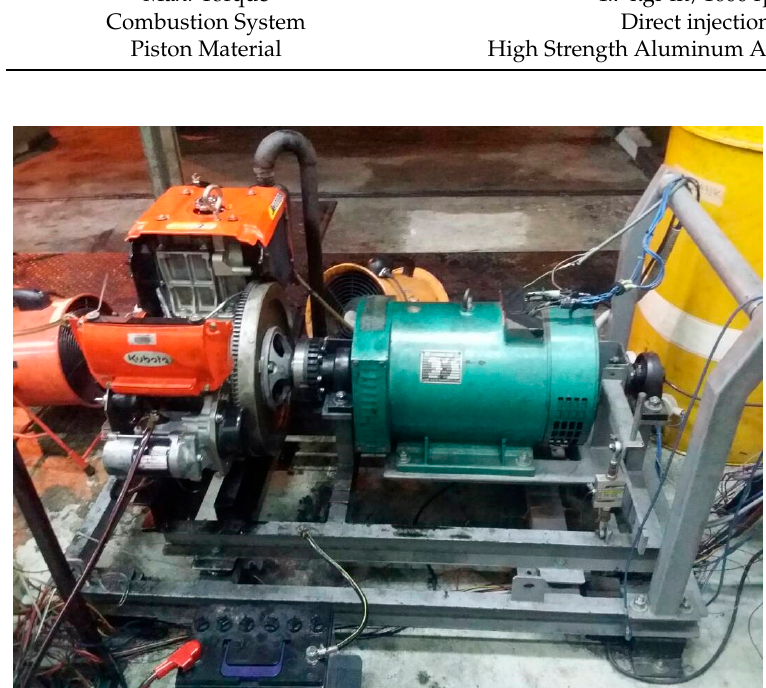
Figure 2. Kubota RT-125 diesel engine experimental setup.